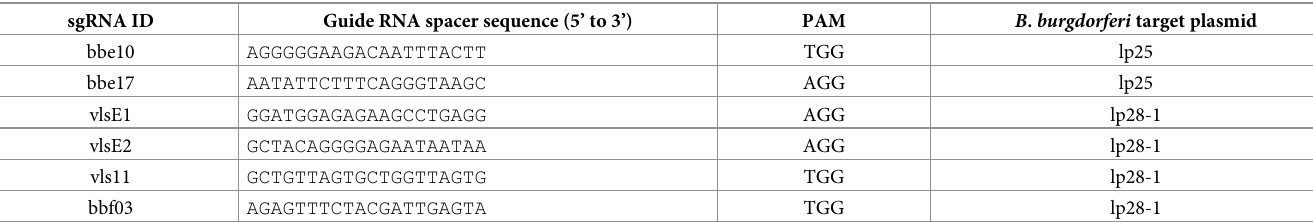
Table 3. sgRNAs used in this study.